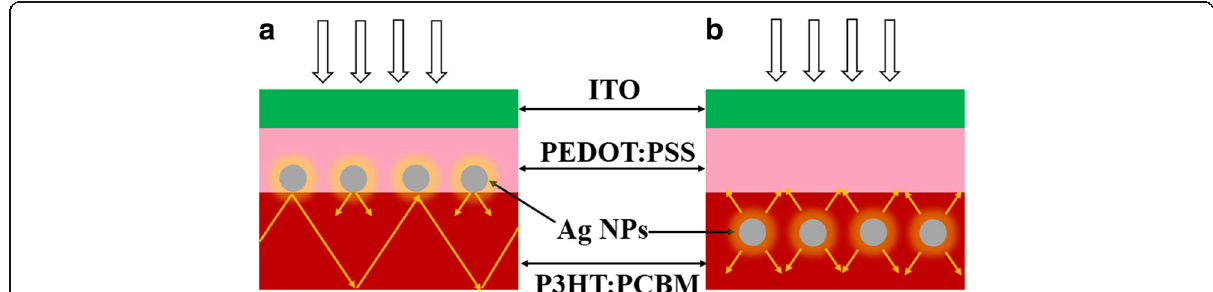
Fig. 2 Schematic illustration of light trapping through scattering and local field enhancement in a NPs located outside of the active layer and b NPs located inside of the active layer